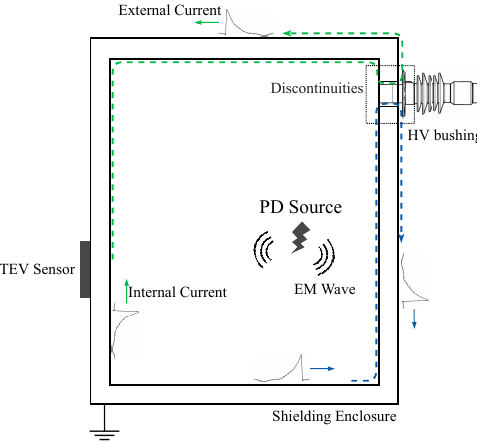
Figure 1. The principle of transient earth voltage (TEV) signal propagation. When partial discharge (PD) occurs inside electrical equipment (simplified to a box), EM waves are emitted. The EM wave leaking from dielectric discontinuities may propagate to the ground through the shield’s outer surface in the form of locally raised voltages (dashed lines). These voltages can be obtained with capacitive sensors and recorded as TEV signals.